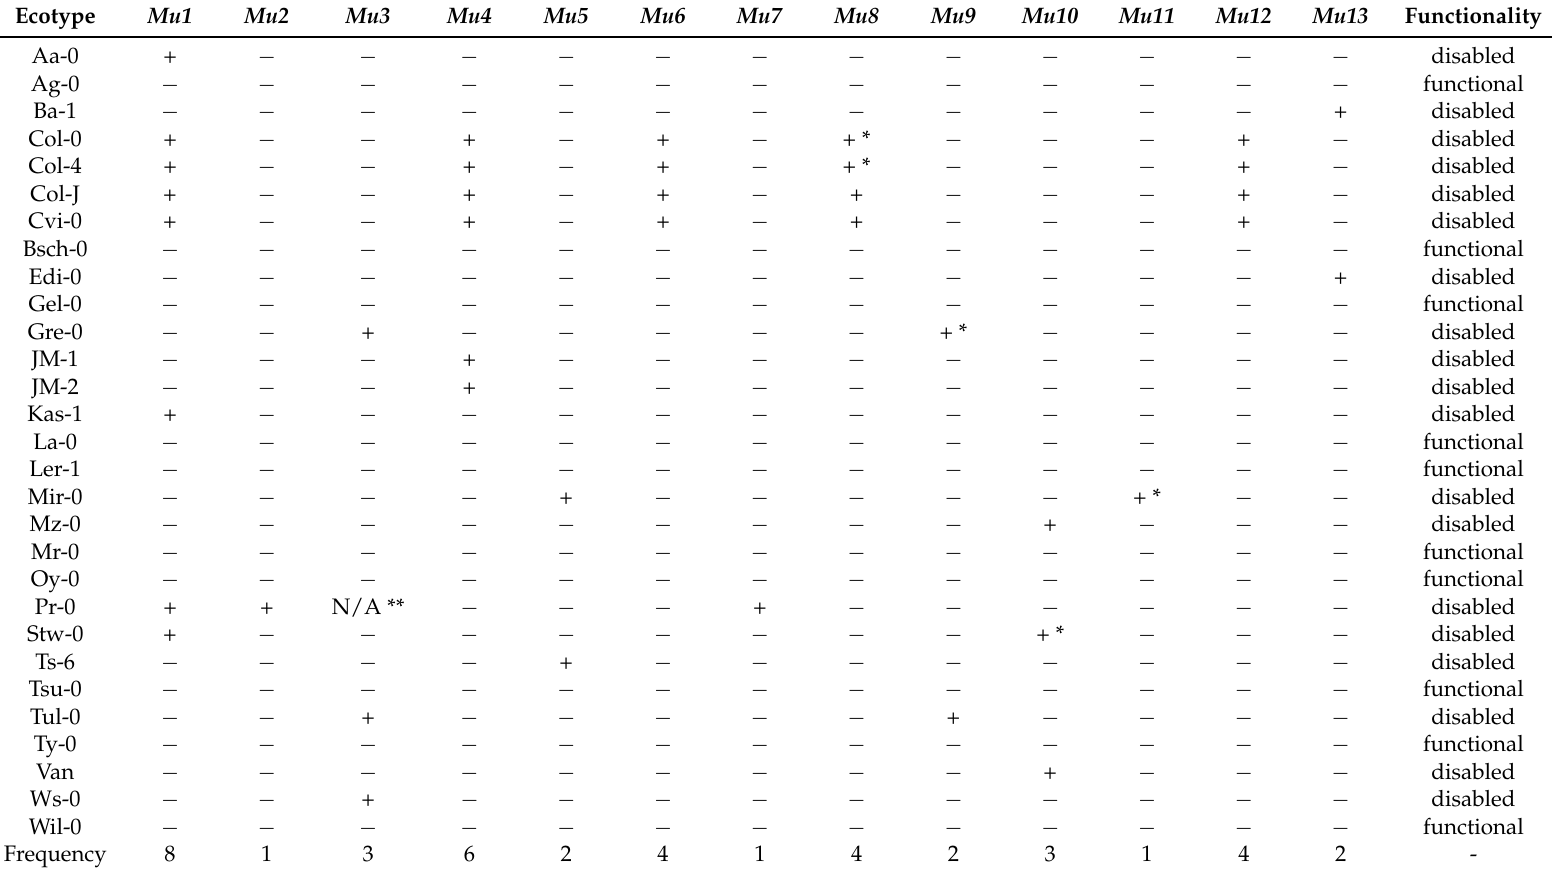
Table 2. Distribution of frame-shift mutations in AtTGG6 alleles among Arabidopsis